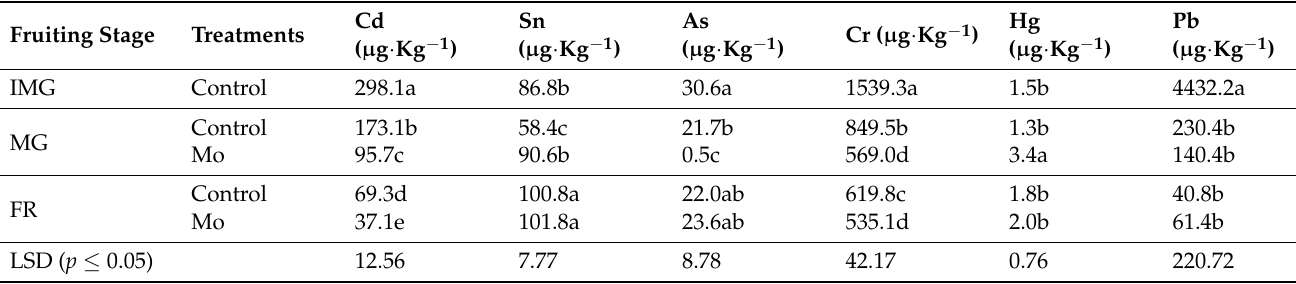
Table 10. Concentrations of heavy metals in fruit pulp of loquat affected by the foliar application of molybdenum. Fruiting Stage